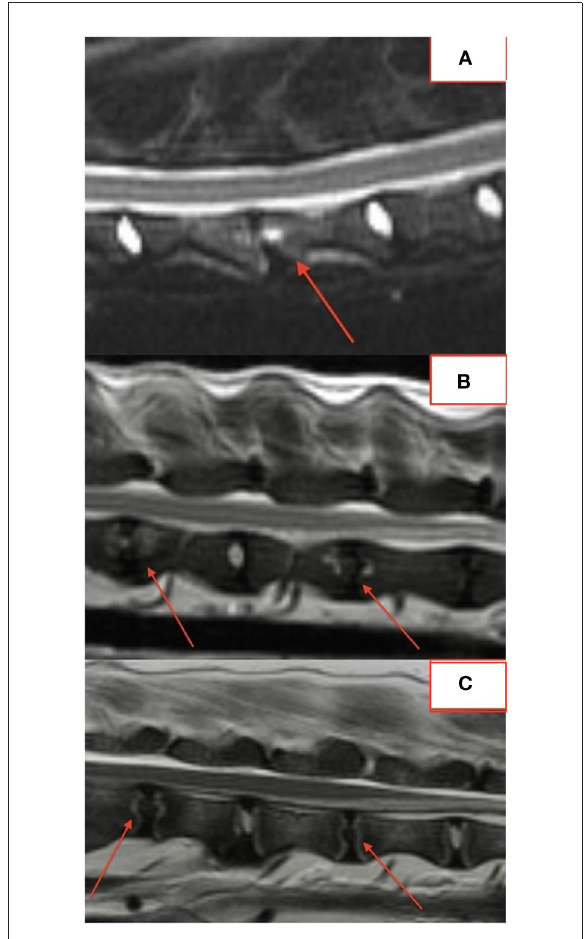
FIGURE2 (A–C) Examples of “hole punch” lesions on MRI.